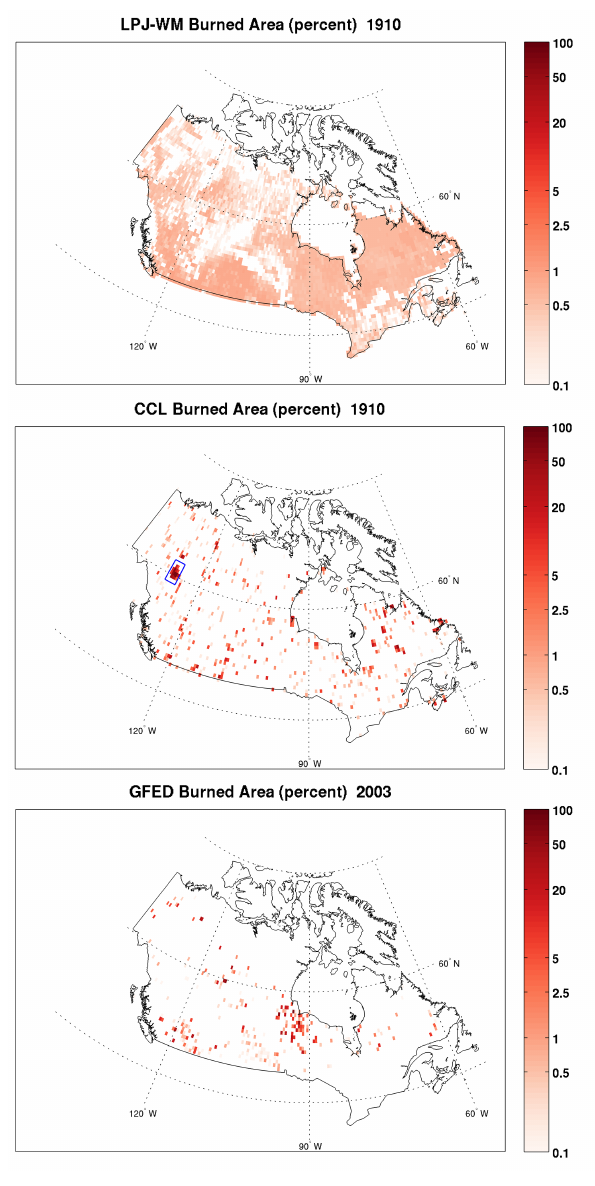
Figure 4. Fractional burned area per grid cell (%) for 2007 in an original LPJ-WM run (top), a CCL run (centre) and GFED (bot- tom). Note that, since the fire is stochastic in the CCL run, different runs would produce different fires for the same year but the overall fraction of area burned would remain equal to that of the original